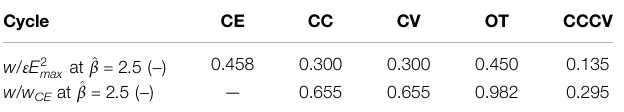
TABLE 5| Representativevaluesofnormalisedenergydensity and relativeenergy density (wrt constant fi eld), for different harvesting cycles. The constant fi eld (CE)cycleisgivenasreference value.Thevaluesarecalculatedusingtheformulas from Moretti et al.